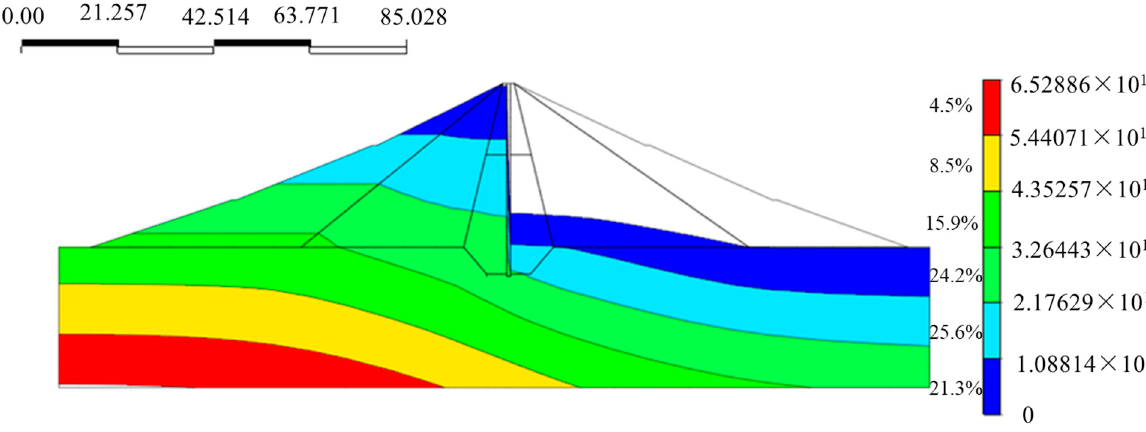
Figure 12. Velocity vector diagram of the checking flood level by the proposed method. 4. Stability Analysis In this program example, finite element analysis of slope stability is calculated by choosing upstream that designs the flood level which is 124.33 m and checks flood level which is 125.12 m. The bottom of the dam foundation and the left and right sides are fixed boundaries, and the dam surface is a free boundary. Calculation parameters are shown in